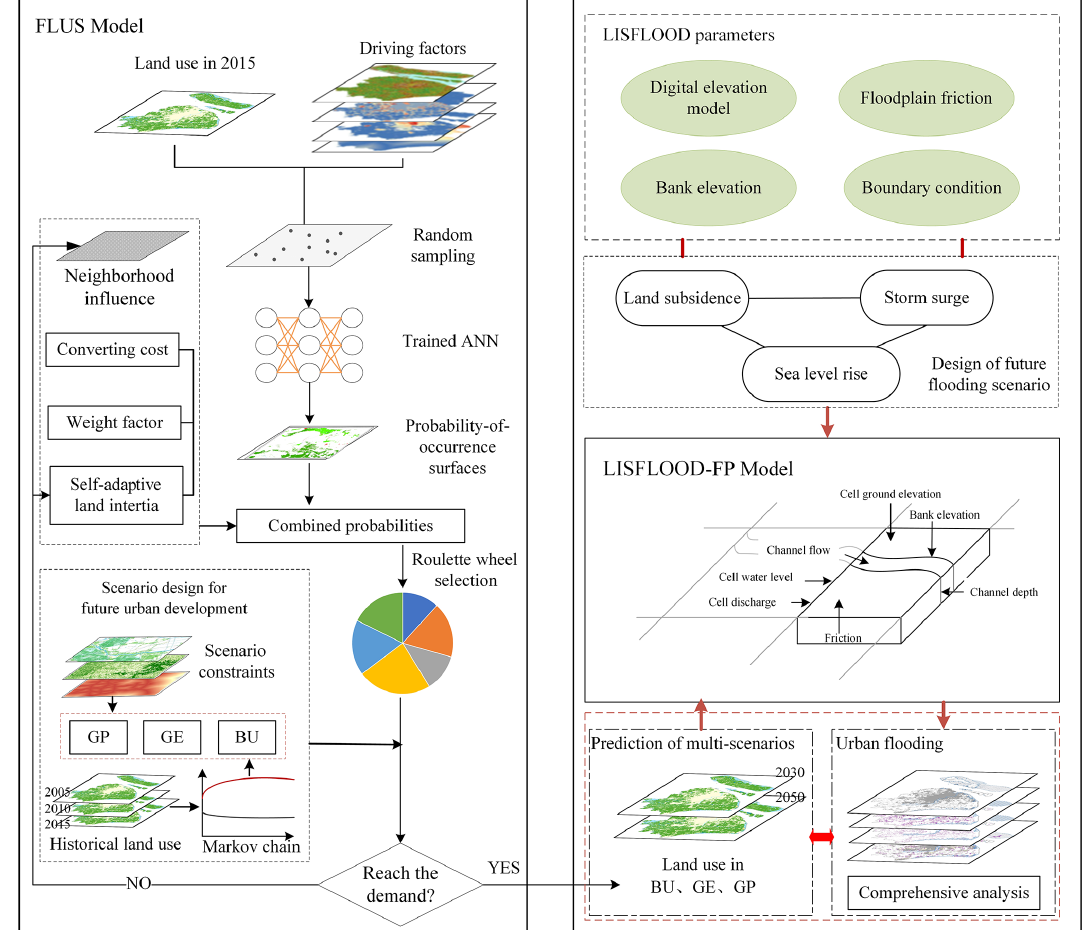
Figure 2. The overall flowchart of research.